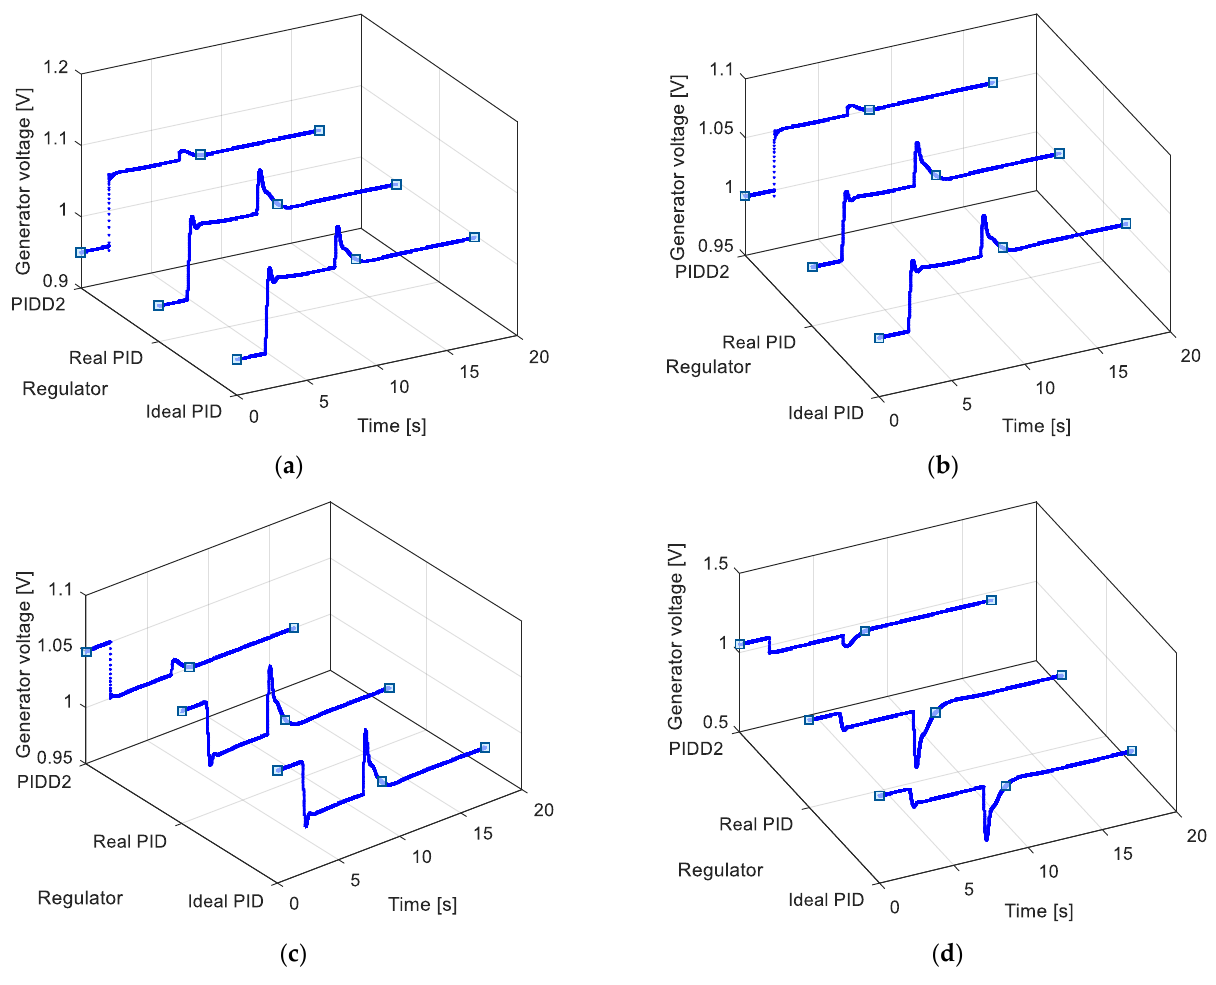
Figure 7. Generator voltage responses for: ( a ) reference voltage change from 0.95 to 1.05 p.u and excitation voltage of 0.5 p.u, ( b ) reference voltage change from 1 to 1.05 p.u and excitation voltage of 0.3 p.u, ( c ) reference voltage change from 1.05 to 1 p.u and excitation voltage of 0.5 p.u, and ( d ) reference voltage change from 1.05 to 0.95 p.u and excitation voltage of 0.3 p.u.